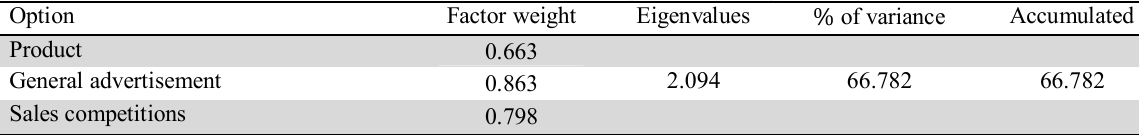
The summary of factors associated with market development